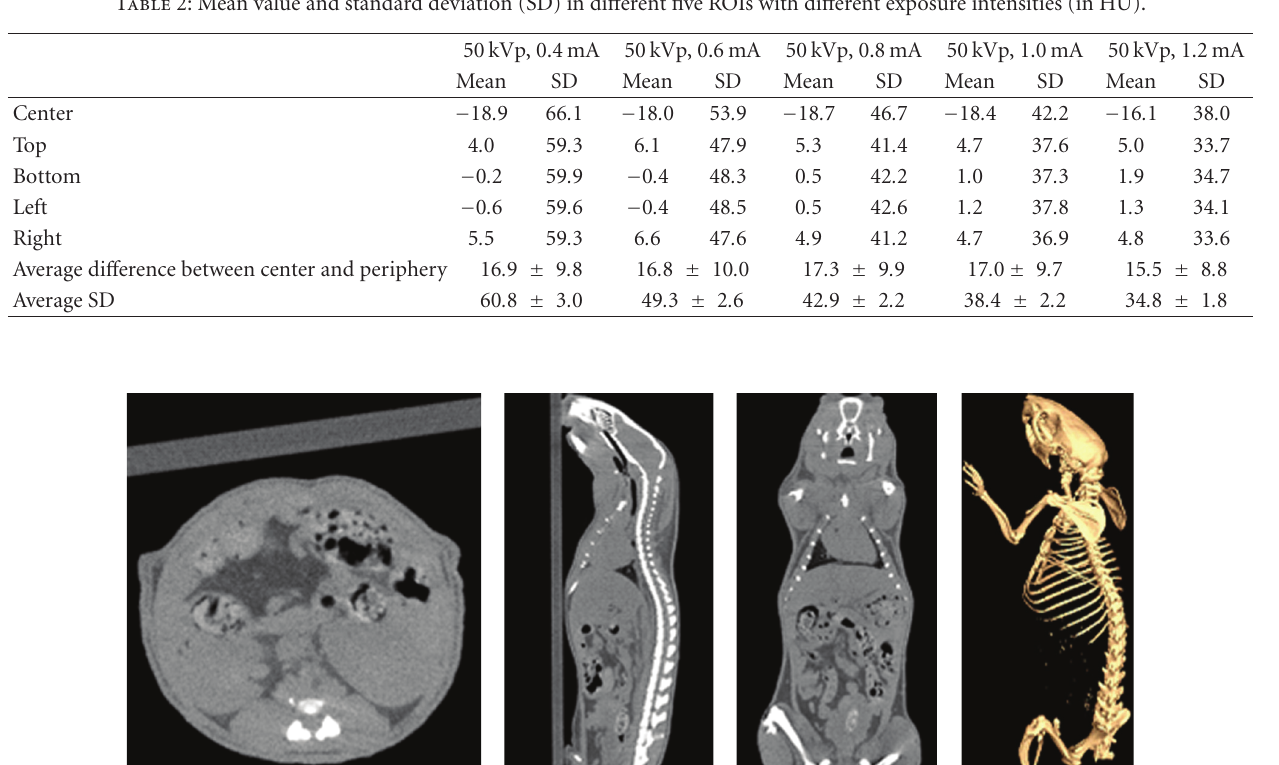
is 0 . 01 × 0 . 01 × 0 . 05 mm 3 . However, 100 slices near the horizontal mid-plane are averaged to reduce the noise e ff ect. shows the modulation transfer function of the cone-bean